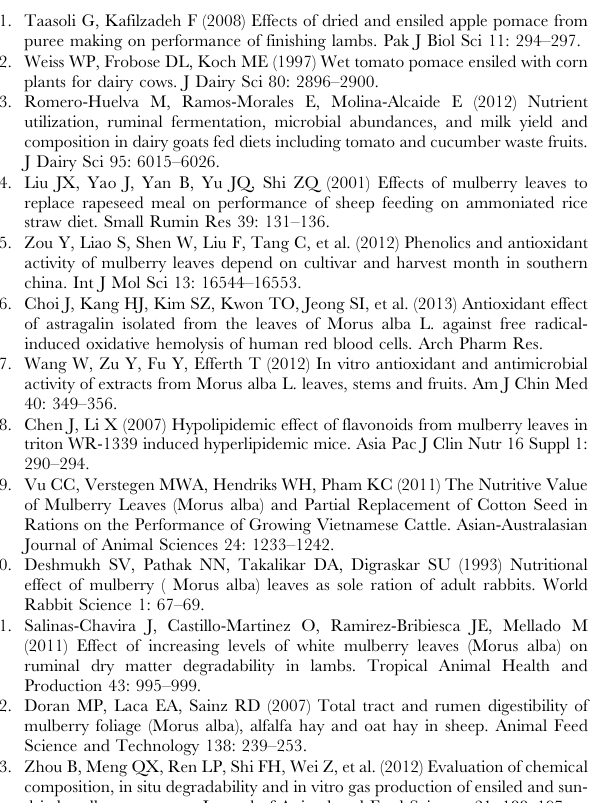
Table S1 Chemical composition and silage fermentation